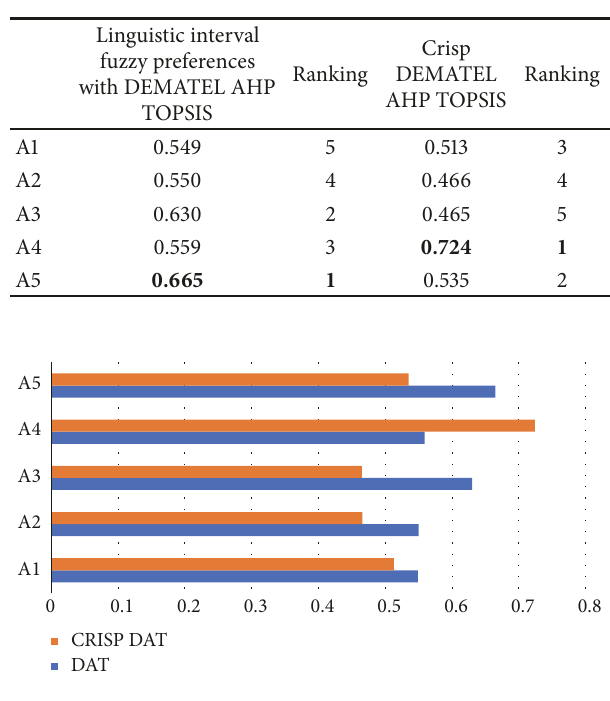
Figure 6: Overall performance of the